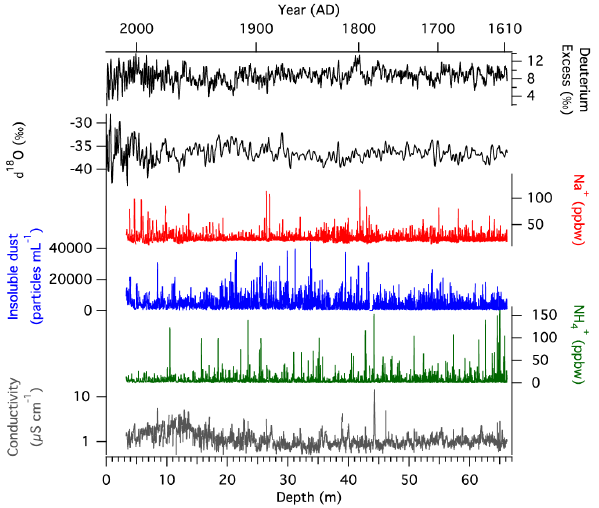
Figure 7. Stable water isotopologues and chemical impurities de- termined in the NEGIS firn core. δ 18 O and deuterium excess were determined in discretely cut ice sampled at 5cm resolution while the impurities were determined from continuous flow analysis mea- surements.